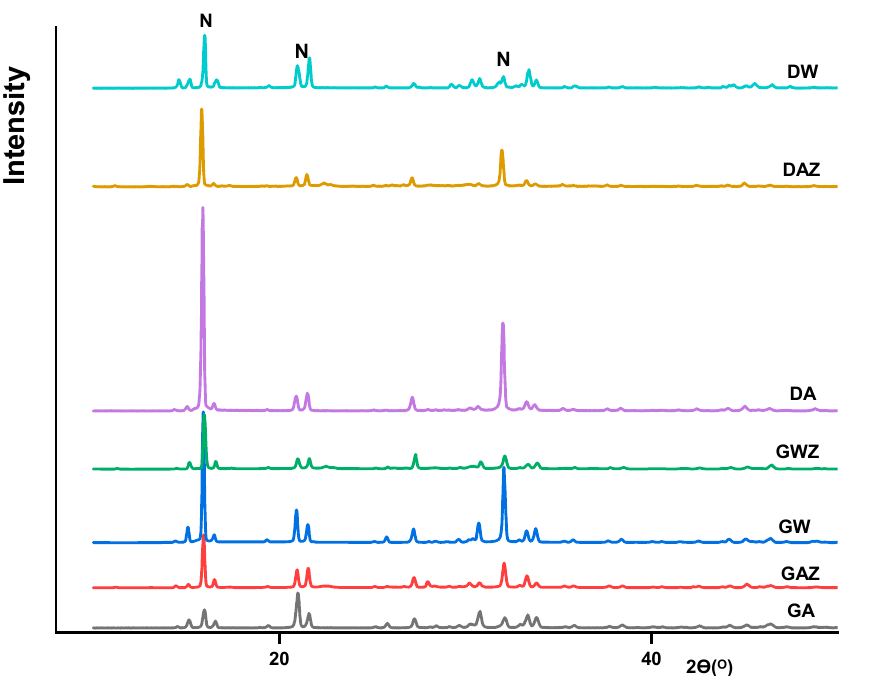
Figure 5. XRD spectra for recovered products from artificial solutions with and without zeolite, respectively.